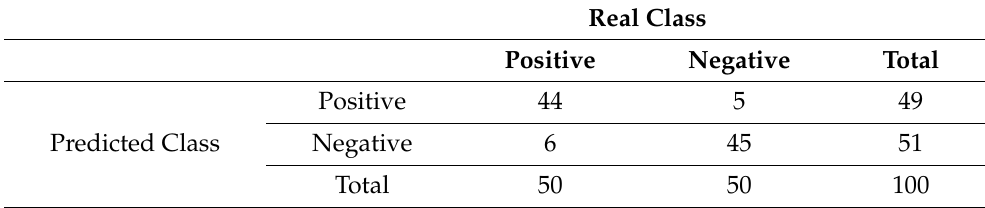
Table 4. Confusion matrix of the results obtained by the SVM-based classifier using a set with 20 features along with the test set containing 100 instances from the first database (IMSS).